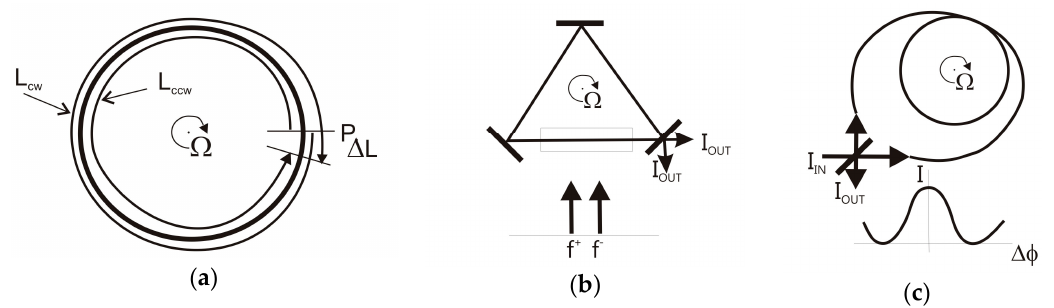
Figure 7. The Sagnac effect in a circular ring interferometer rotating with respect to an inertial frame of reference: ( a ) interferometric systems for its detection; ( b ) active method in the ring-laser approach; ( c ) passive method in a fibre-optic interferometer approach. Notation: L cw , L ccw —distances in clockwise and counterclockwise directions; I IN , I UOT —intensities of input and output beams respectively [77].